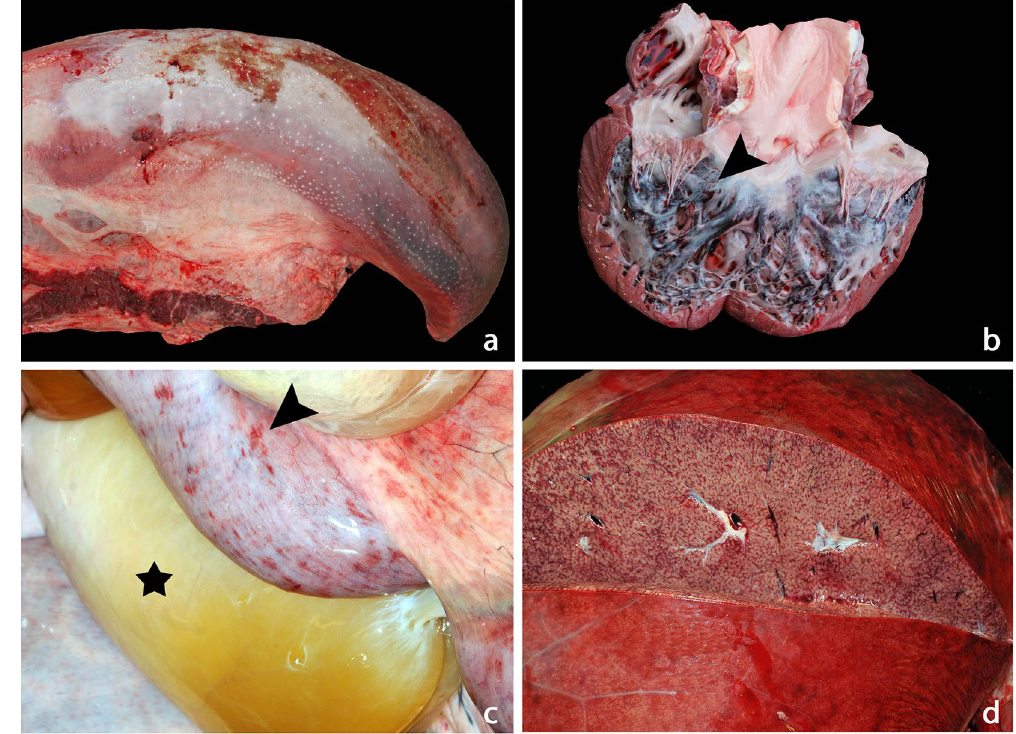
Figure 1. Representative gross lesions from Asian elephant endotheliotropic herpesvirus-haemorrhagic disease fatalities. ( a ) Case 5. Tongue after pluck removal. There is diffuse lingual swelling and cyanosis. ( b ) Case 5. Heart, sectioned. Severe subendocardial petechial (arrow head), ecchymosal and suffusive haemorrhages are present. ( c ) Case 26. Abdominal cavity, view of intestines and mesentery. The small intestine presents with multifocal petechial to ecchymosal serosal and subserosal haemorrhages (arrow head). Extensive oedema expanding the mesentery (star). Image courtesy of Jonathan Cracknell. ( d ) Case 26. Liver, removed and sectioned. The liver is swollen with a taut capsule and bulging cut surfaces. Multifocal subcapsular haemorrhages are evident. Hepatic parenchyma has an enhanced lobular pattern with irregular